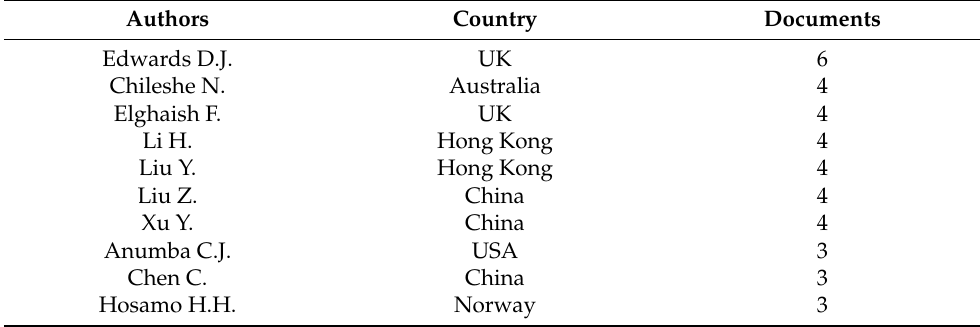
Table 4. Most relevant authors analysis performed with Biblioshiny version 4.0.